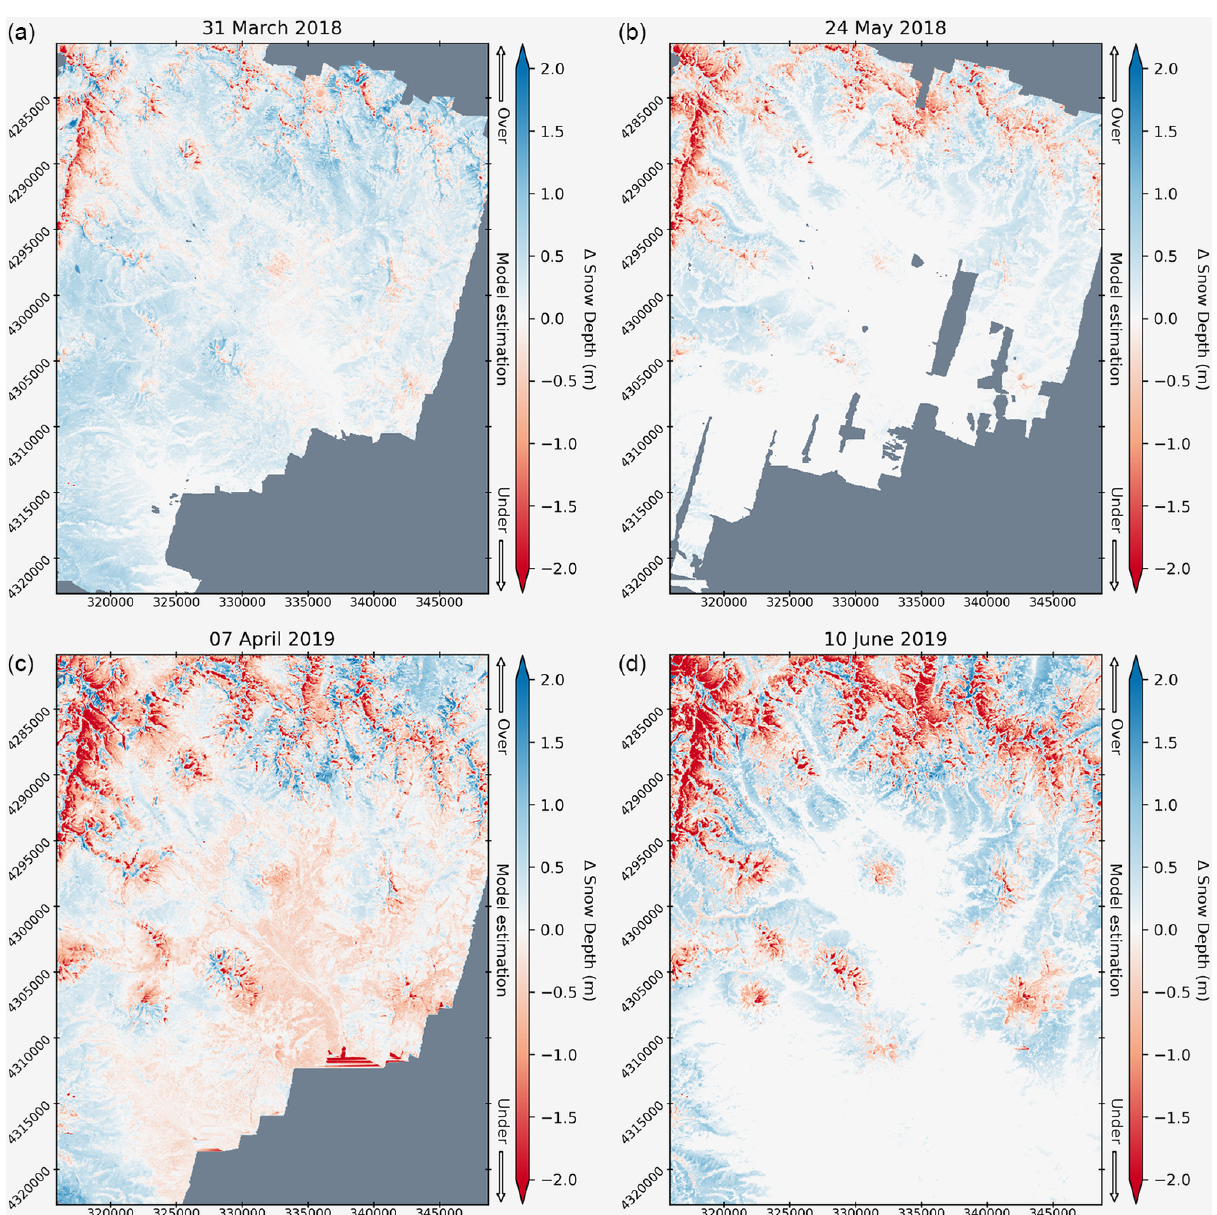
Figure 6. Spatial comparison of simulated HRRR-iSnobal against observed ASO lidar-based snow depths for 2018 and 2019. Early sur- veys (a, c) and late surveys (b, d) subtracted ASO values per grid cell from HRRR-iSnobal (50m